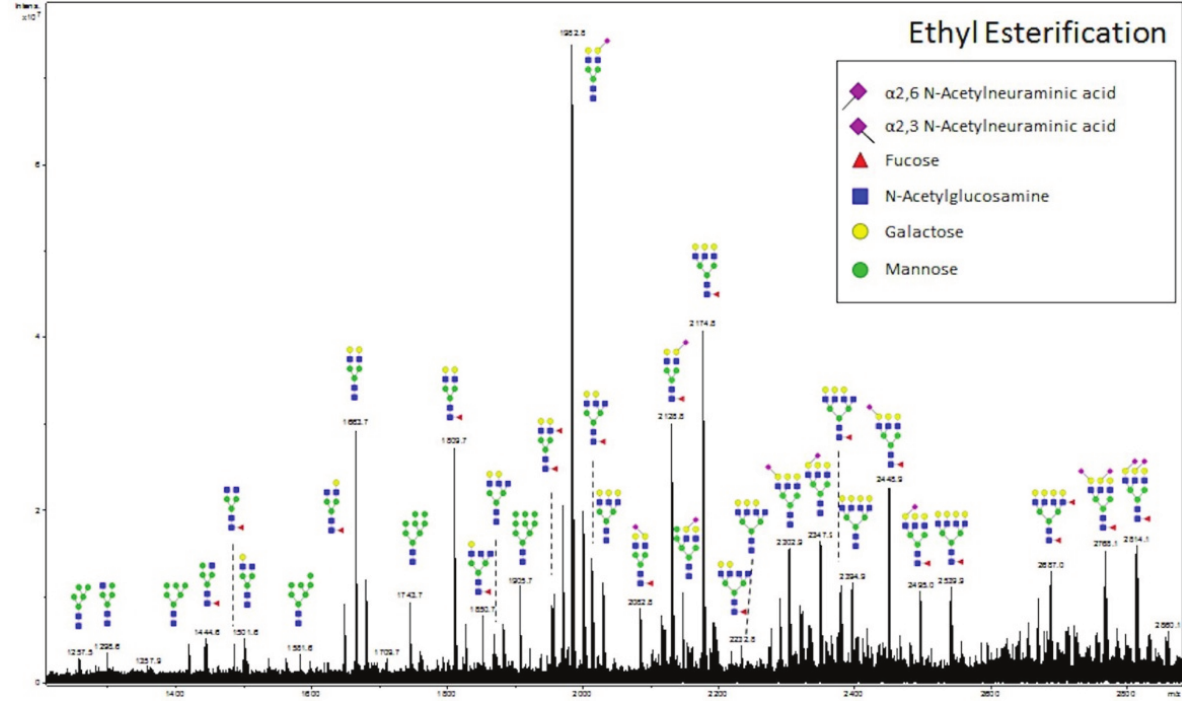
Figure 4. Off-Tissue Ethyl Esterification of HCC Glycans Correlates with MALDI-IMS Results. N -glycans extracted from HCC tissue sections were modified by ethyl esterification followed by cotton HILIC tip enrichment [22,26]. Enriched glycans were spotted on a MALDI plate and analyzed in positive ion mode by MALDI-FTICR. The core fucosylation in the indicated structures has yet to be confirmed by other